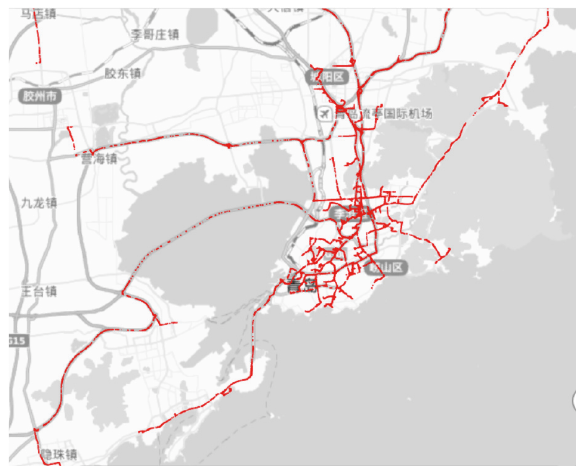
Figure 5: Recommendation routes of the 300 OD